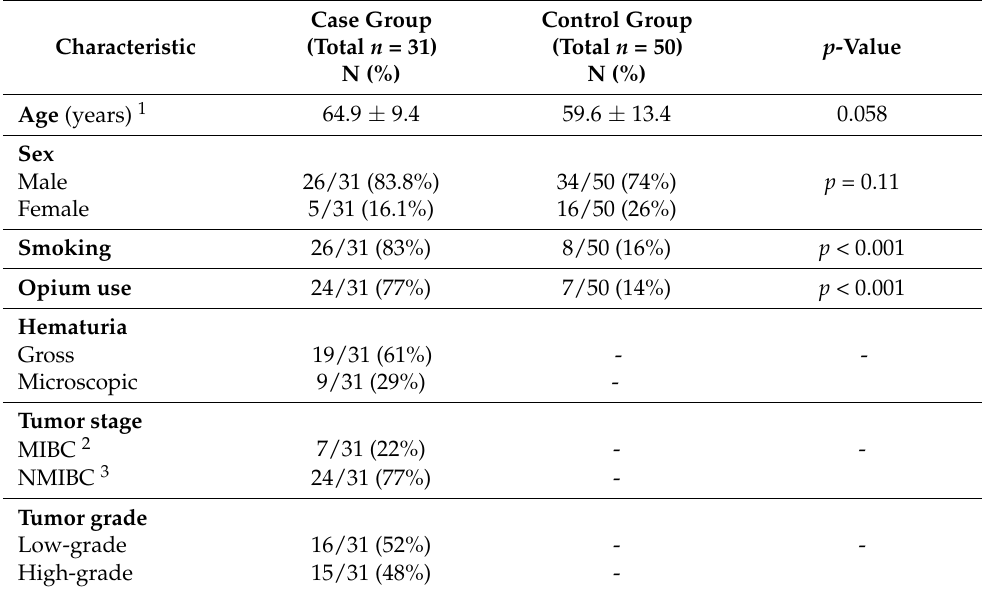
Table 1. Distribution of demographics and selected exposures among participants in the case and control